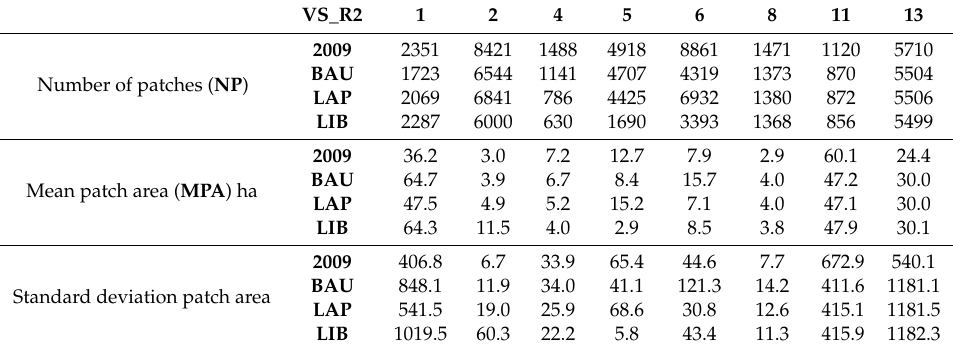
Table 11. Landscape fragmentation parameters for VS_R2: number of patches (NP), mean patch area (MPA) in ha, and standard deviation of the mean patch area, in 2009 and 2050 for each scenario and land use